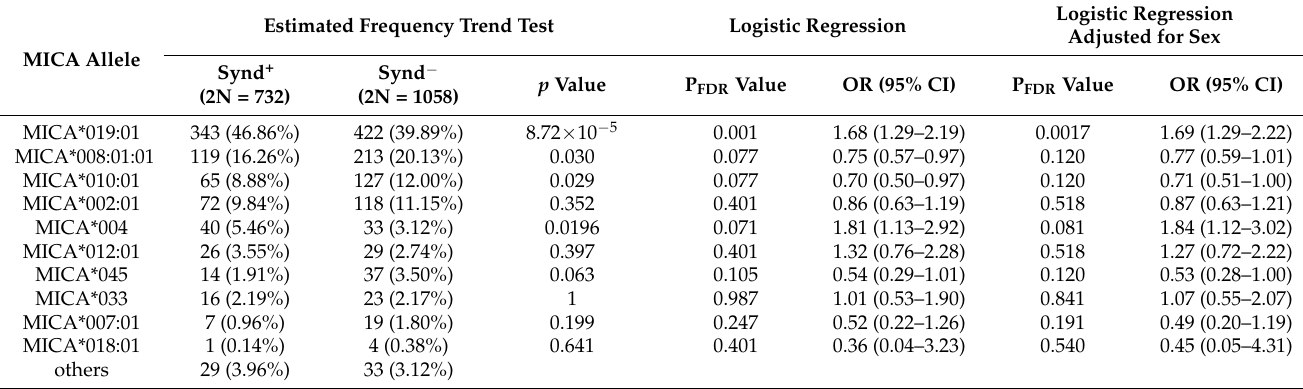
Table 2. Comparison of MICA allele frequencies between AS patients positive for syndesmophyte formation (Synd + ) and AS patients negative for syndesmophyte formation (Synd − ).